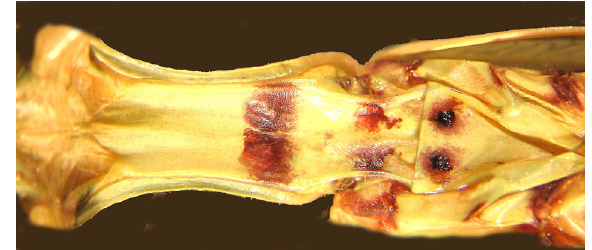
Image 4. Bands and nipple like tubercles on sterna